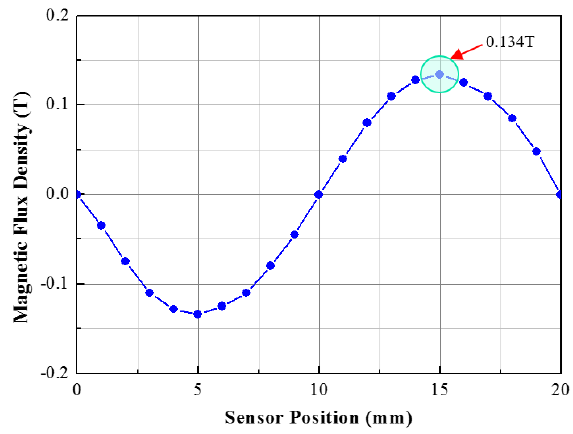
Figure 5. Distribution of flux density with the 2D initial model of the sensor module.